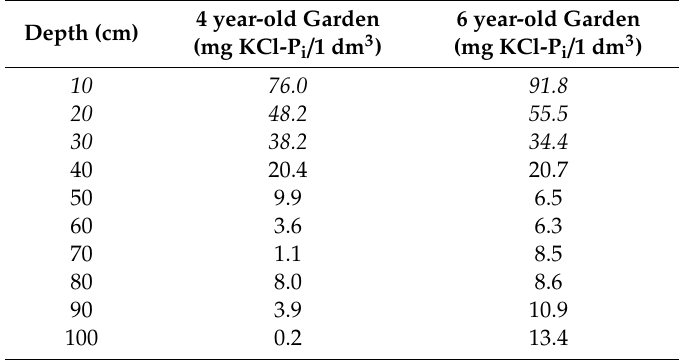
Table 3. Average excess KCl-P i (garden plot–control plot) on volumetric basis by depth layer. Each value represents excess KCl-P i in 1 dm 3 (10 cm × 10 cm × 10 cm), allowing for values to be vertically integrated. Depths ≤ 30 cm (italicized) were a garden soil / compost mixture; depths > 30 cm is native